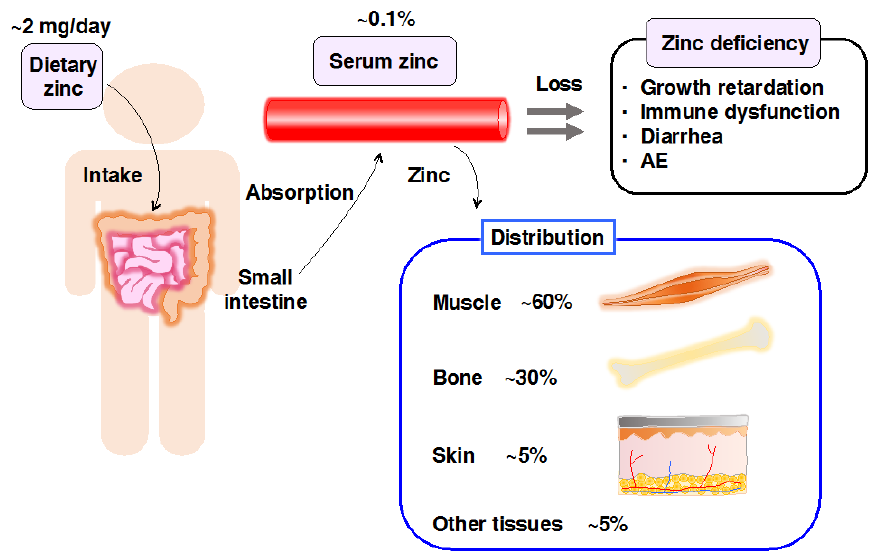
Figure 1. Scheme for Zinc (Zn) storage and distribution in the body. Dietary Zn is absorbed in the small intestine and distributed to the peripheral tissues, including skeletal muscle (60%), bone (30%), skin (5%), and other tissues (5%). Zn deficiency causes various abnormalities in humans and animal models, such as growth retardation, immune dysfunctions, diarrhea, and skin diseases, including acrodermatitis enteropathica (AE).